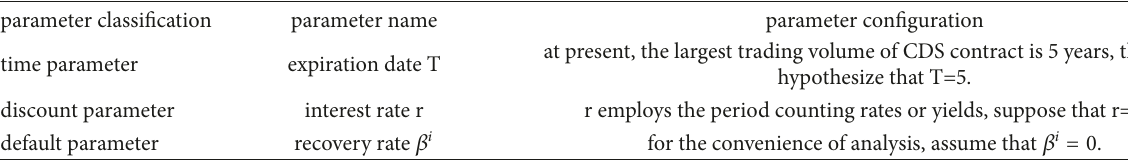
Table 1: The parameter configuration.